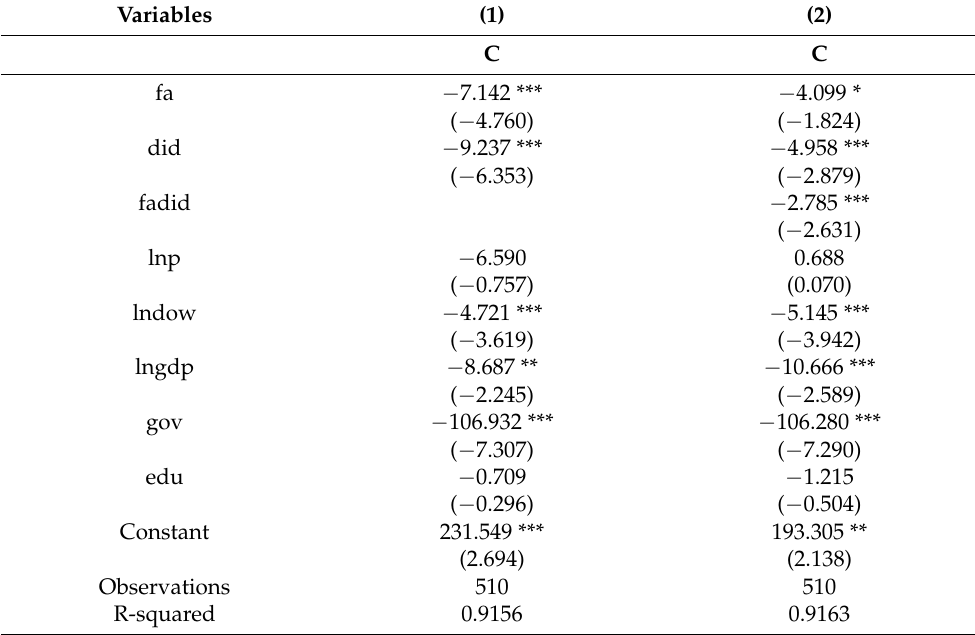
Table 6. Test results of regulation